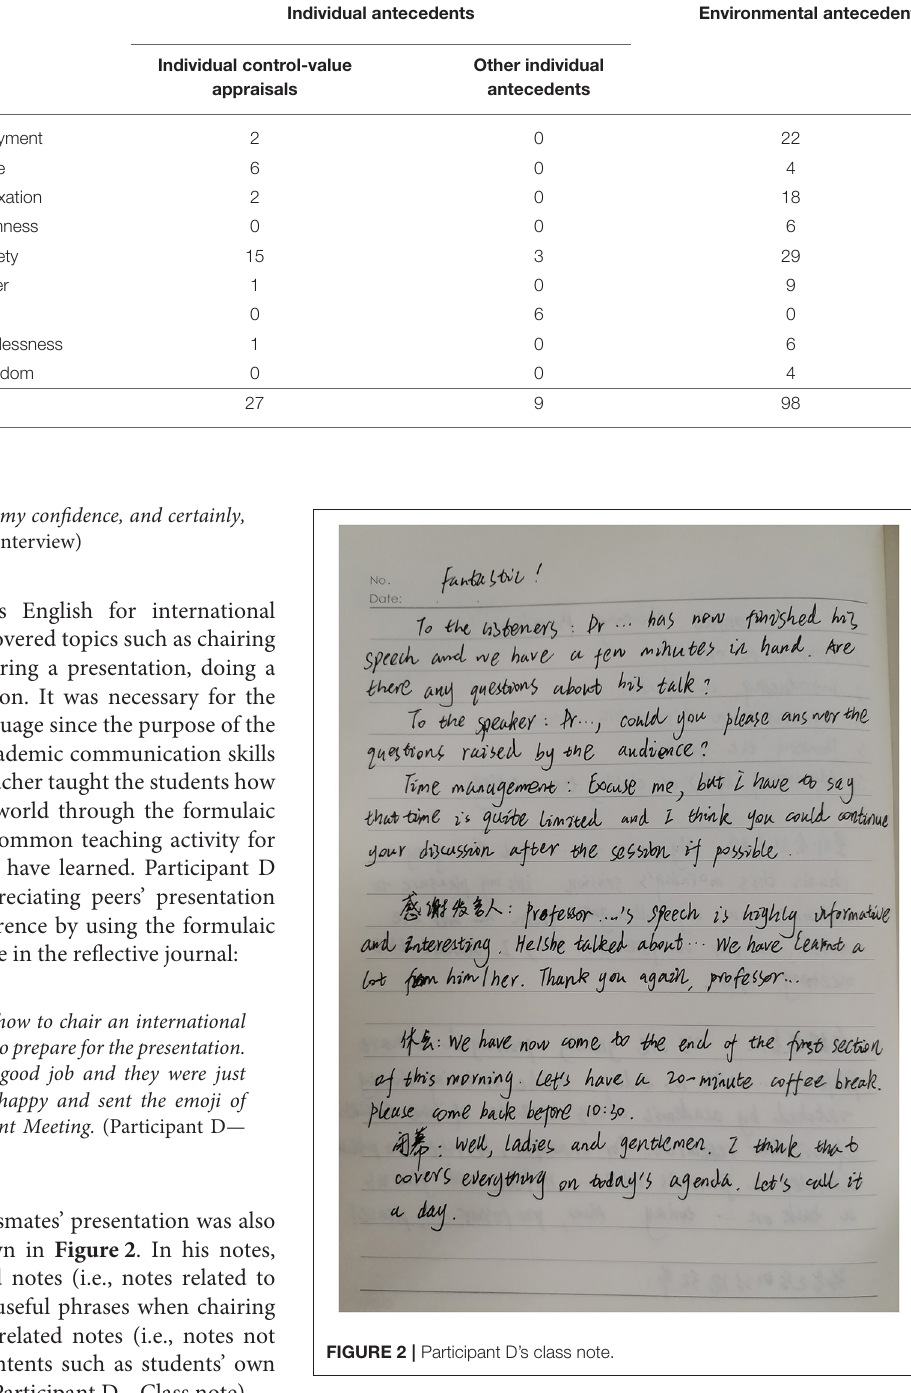
Individual antecedents